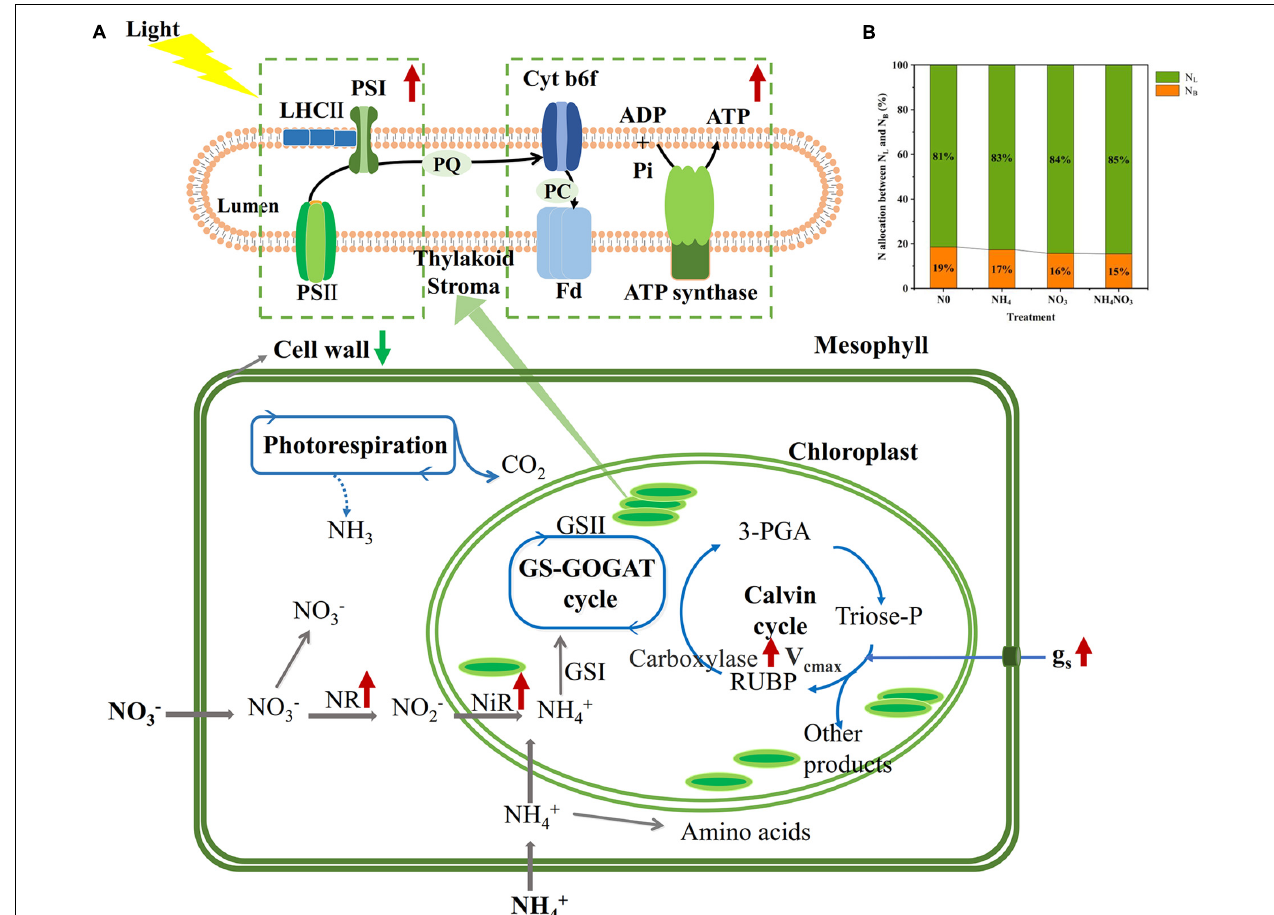
FIGURE 4 | Effect of N forms treatments on the change of N contents in photosynthetic apparatus of leaves in L. chinensis . (A) The percentage together with indicate the increase (red arrows) and the reduction (green arrows) of N in different photosynthetic apparatus under NO 3 compared to N0, NH 4 , and NH 4 NO 3 treatments. (B) The allocation of N between PN B and PN L within the thylakoid lumen under N0, NH 4 , NO 3 , and NH 4 NO 3